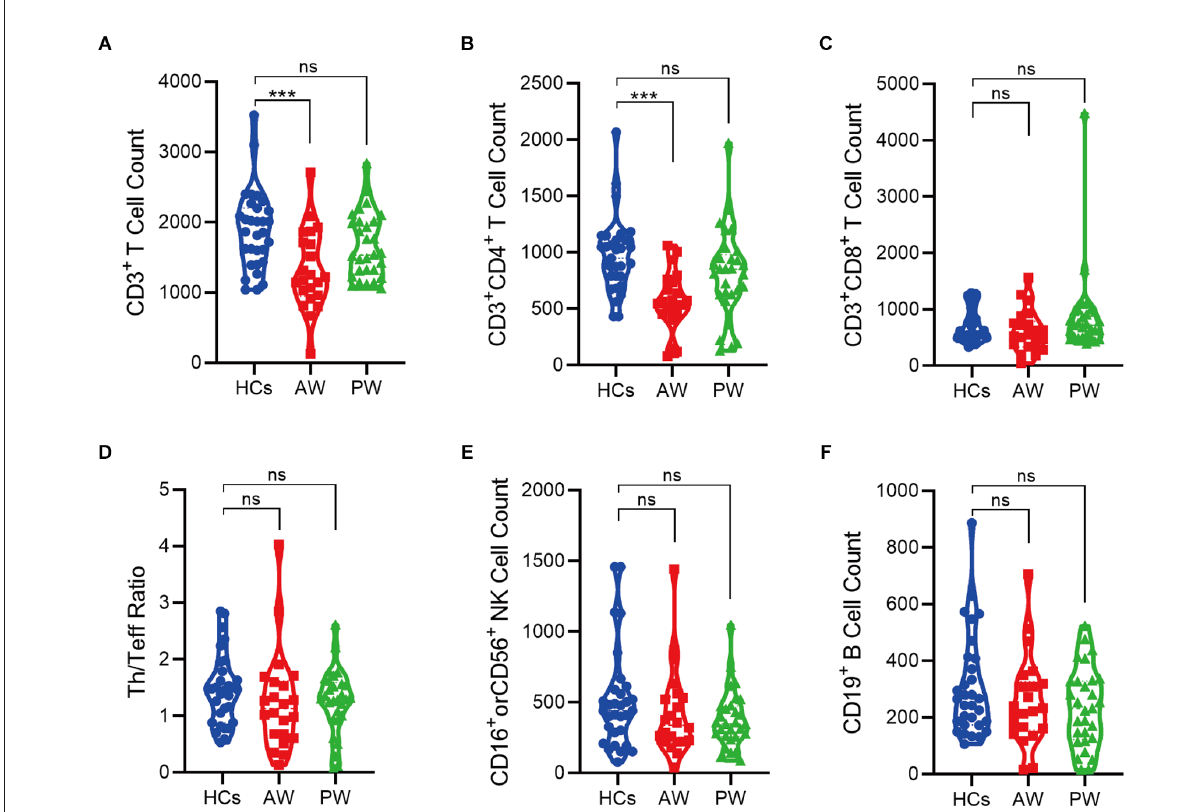
FIGURE1 Alterations of peripheral immune cell subsets in patients undergoing methamphetamine (METH) withdrawal. (A–F) Total T cell count (CD3 + ) (A) , Th cell count (CD3 + CD4 + ) (B) , Teff cell count (CD3 + CD8 + ) (C) , Th/Teff ratio (CD3 + CD4 + / CD3 + CD8 + ) (D) , NK cell count (CD16 + or CD56 + ) (E) , and B cell count (CD19 + ) (F) in the MUDs patients during withdrawal. HCs, healthy controls; AW, acute withdrawal; PW, protracted withdrawal. *** p < 0.001; ns, no significant